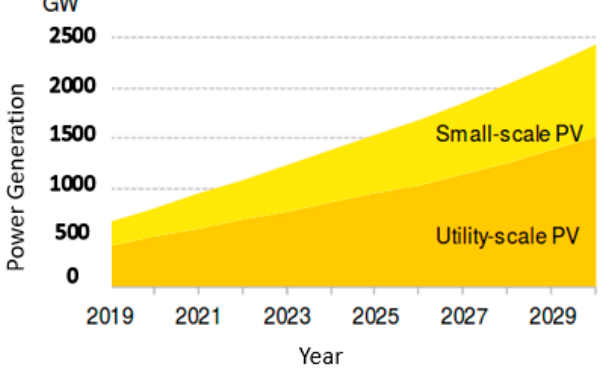
Figure 2. Total global Photovoltaic rooftop and utility-scale generation 2019–2029 [25].